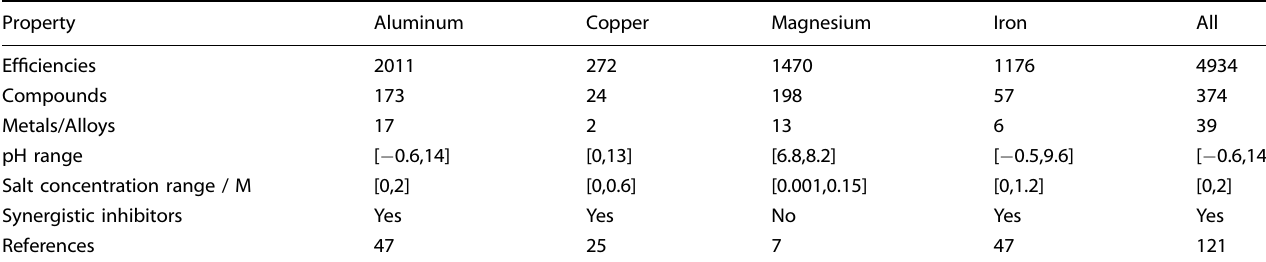
Table 1. Overview of the data included in the CORDATA database for different metals and respective alloys.